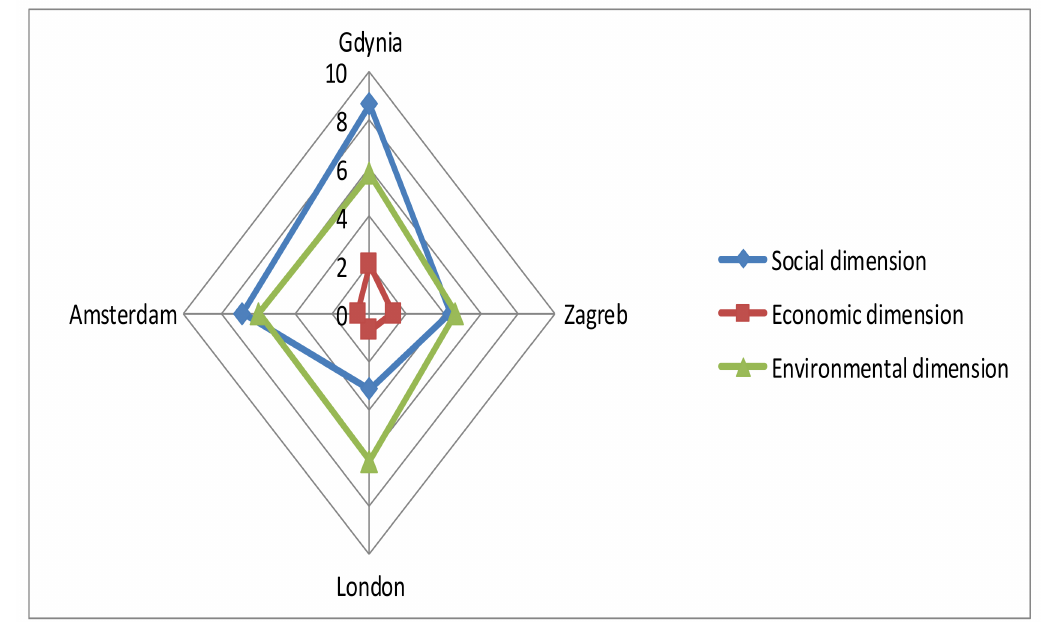
Figure 3. Differences in the value of total utility between the compared cities with regard to the analyzed